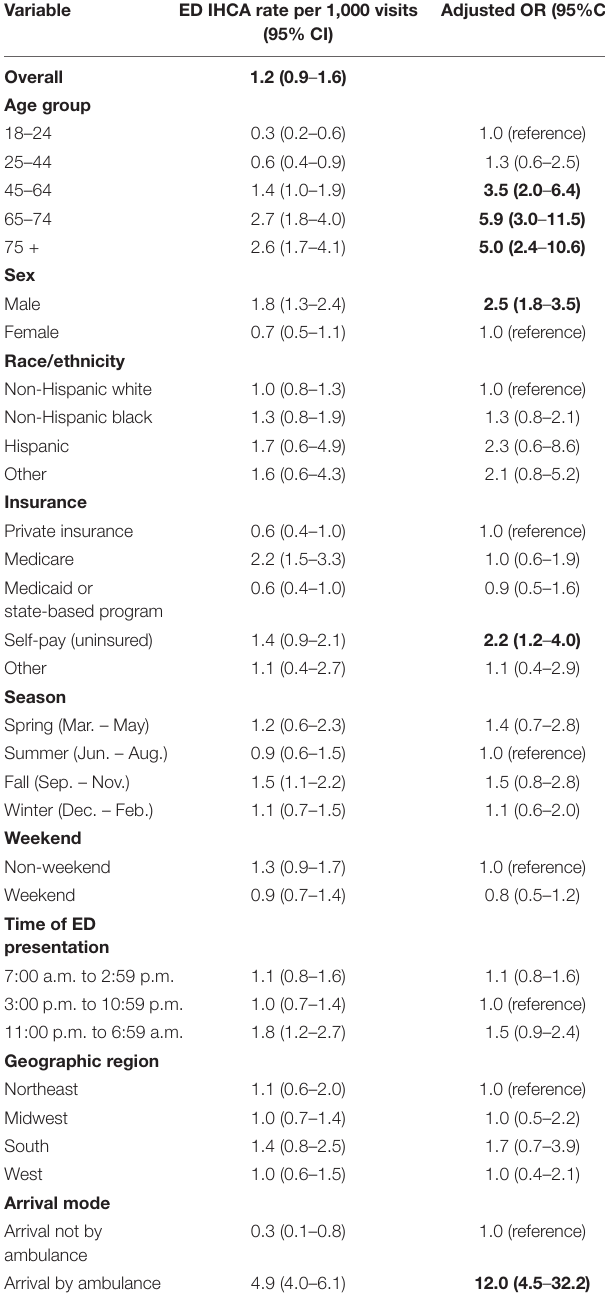
TABLE 2 | Emergency department in-hospital cardiac arrest visit rates, overall, stratified, and multivariable analysis,